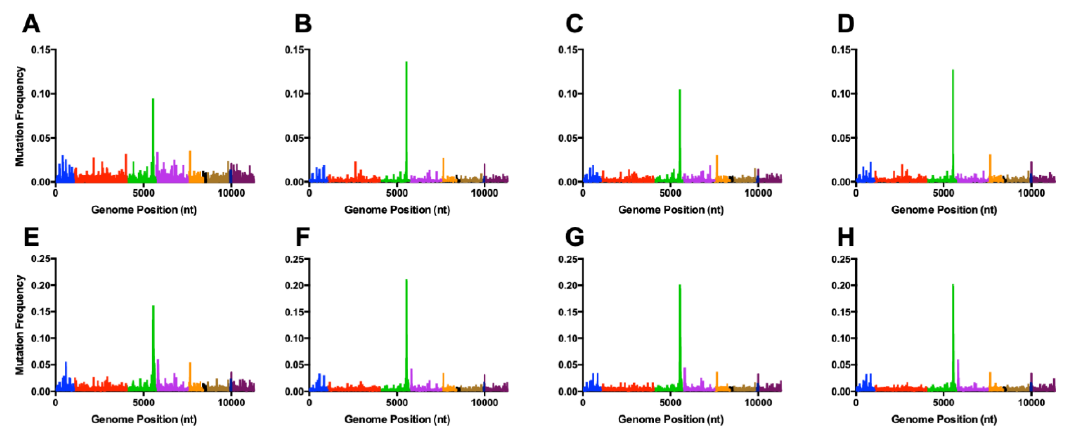
Figure 4. Mutation frequency of VEEV TC-83 E3 ∆ 56-59 mutants at coding regions across the genome. VEEV TC-83 E3 ∆ 56-59 ( A , E ), VEEV TC-83 E3 ∆ 56-59 nsP4-G14R ( B , F ), VEEV TC-83 E3 ∆ 56-59 nsP4-A96T ( C , G ), and VEEV TC-83 E3 ∆ 56-59 nsP4-C488Y ( D , H ). Panels A-D have been analyzed using Analysis A. Panels E-H have been analyzed using Analysis B. Graphs show a representative of each specific mutant. Blue = nsP1, red = nsP2, green = nsP3, purple = nsP4, orange = capsid, black = E3, gold = E2, navy blue = 6k, maroon =